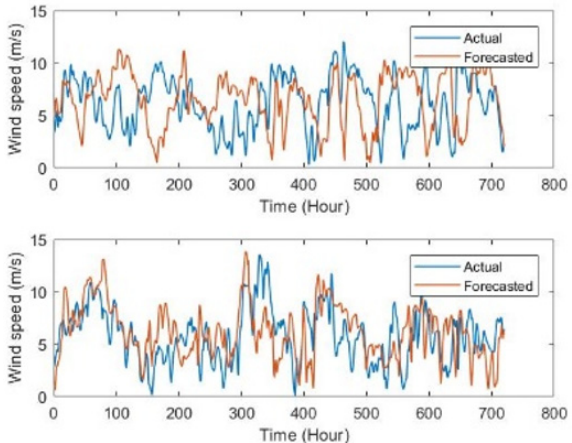
Figure 16. Forecasted and actual wind speeds of 2017, Jan & Feb, Jubail, Case II.